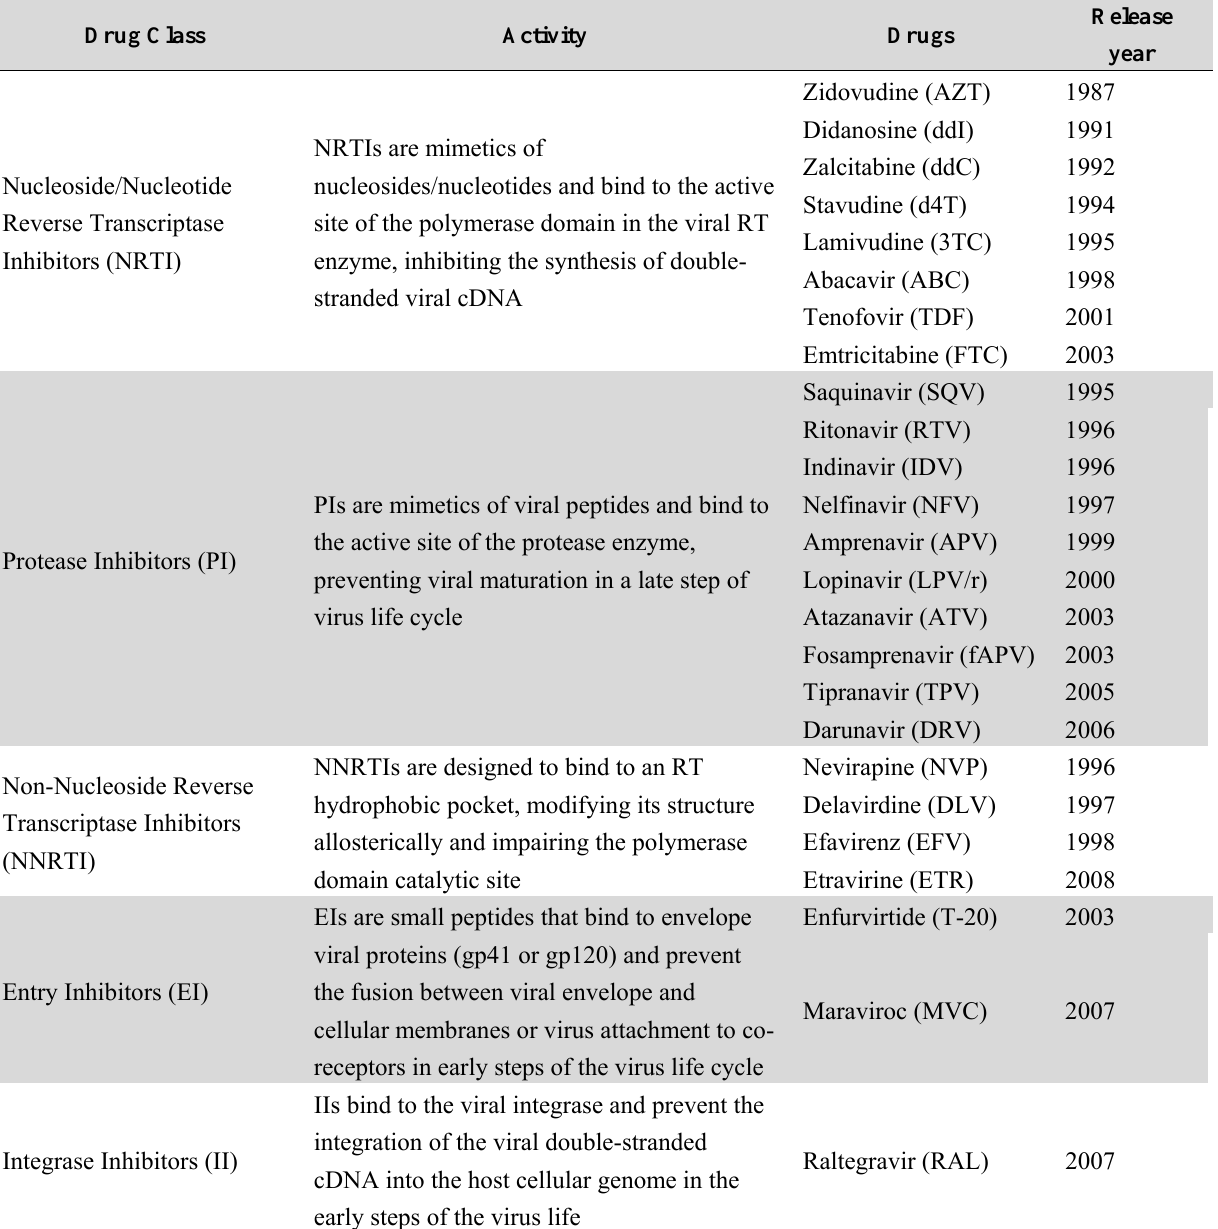
Table 2. Summary of antiretroviral drug